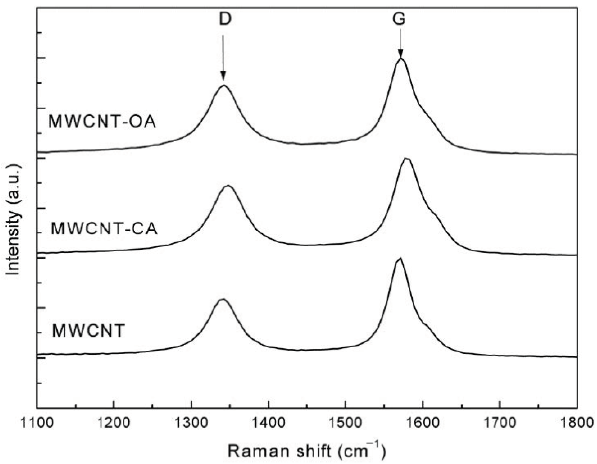
Figure 3. Raman spectra of MWCNT, MWCNT-CA and MWCNT-OA.